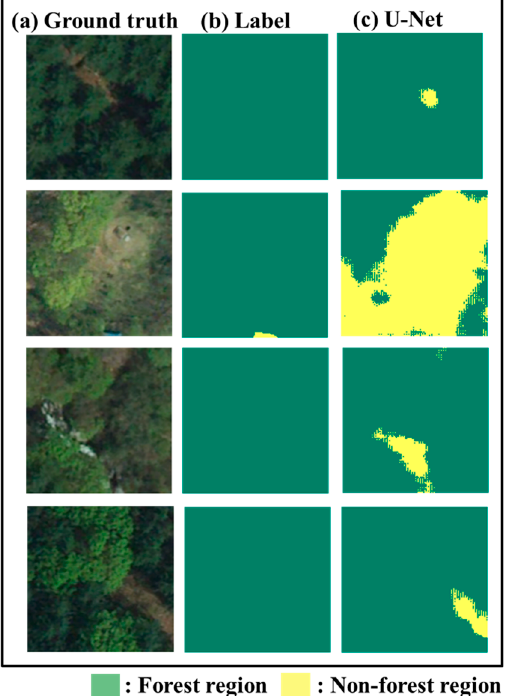
Figure 7. U-Net validation results that had incorrect class labels. ( a ) indicates the RGB images of ground truth in segmented area, ( b ) presents label images of forest and non-forest regions denoting to 0 and 1, respectively, and ( c ) is the forest classification results of U-Net in each image pixel. Green color denotes the forest areas while yellow indicates non-forest areas.